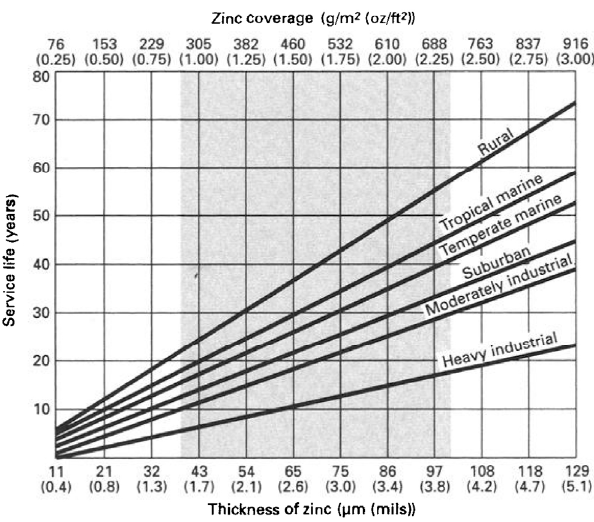
Fig. 18 Service life (time to 5% rusting of steel surface) at different atmospheres as a function of the galvanized coating thickness. Reproduced with permission from Ref. [27], © ASM International,